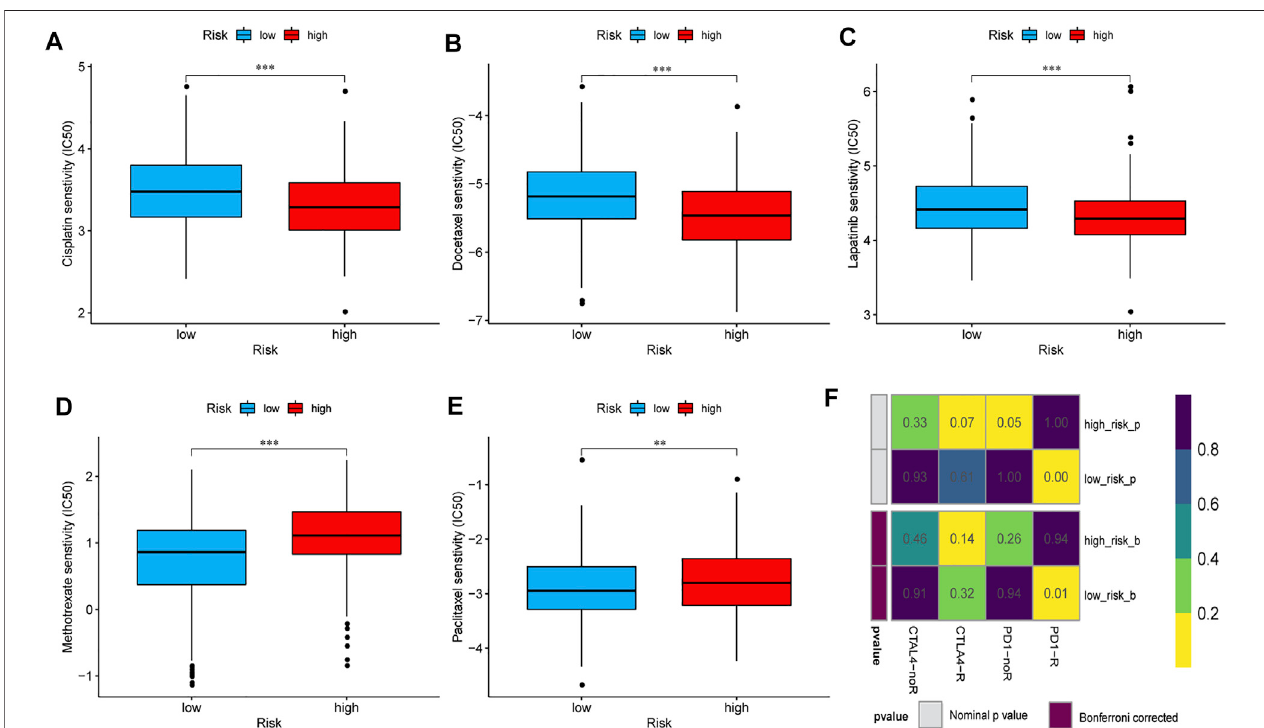
FIGURE 8 | Sensitivities of patients in the high- and low-risk groups to chemotherapy and immunotherapy. The differential chemotherapeutical sensitivities to cisplatin (A) ,docetaxel (B) ,lapatinib (C) ,methotrexate (D) ,andpaclitaxel (E) inthetworiskgroups. (F) SensitivitytoPD1andCTLA4inhibitorsofpatientsinthelow-and high-risk groups. Abbreviations: CTLA4, cytotoxic T lymphocyte-associated protein 4; PD1, programmed cell death